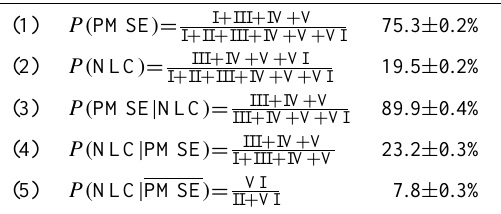
Table 2. Probabilities of PMSE and NLC occurrence for different selection criteria. Statistical errors were calculated as in Fiedler et al. (2009). Figure 4 visualizes the sets used in these equa- tions. Note that the total and conditional probabilities are con- nected by the law of total probability, which is, in our notation, P( PMSE ) = P( PMSE | NLC ) · P( NLC ) + P( PMSE | NLC ) · P( NLC )